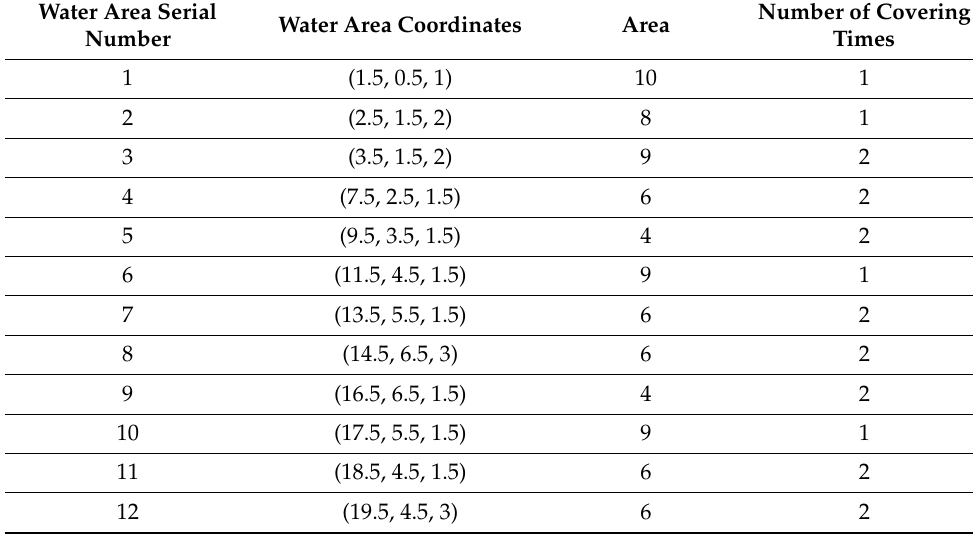
Table 5. Relevant information of water